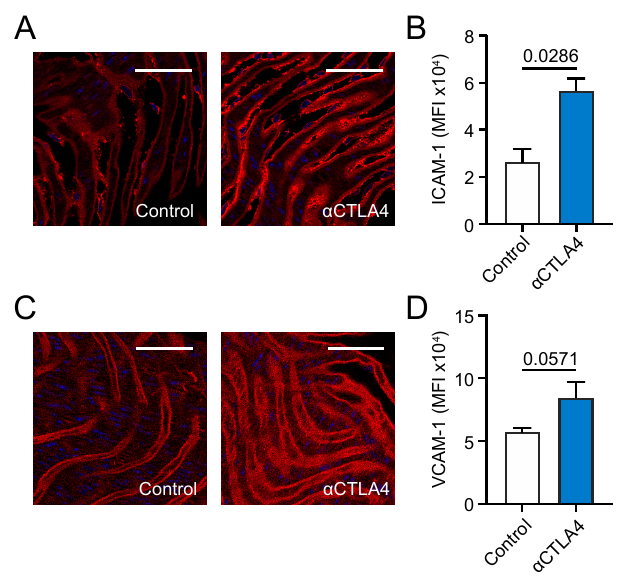
Figure 2. Antibody-mediated inhibition of CTLA4 aggravates endothelial activation in Ldlr − / − mice. ( A ) Representative pictures of the en face expression of ICAM1 on the endothelium of the abdominal aorta. Scale bar: 50 µ m. ( B ) Quantification of the en face expression of ICAM1 by confocal microscopy on the endothelium of the abdominal aorta ( n = 4). ( C ) Representative pictures of the en face expression of VCAM1 on the endothelium of the abdominal aorta. Scale bar: 50 µ m. ( D ) Quantification of the en face expression of VCAM1 by confocal microscopy on the endothelium of the abdominal aorta ( n = 4).